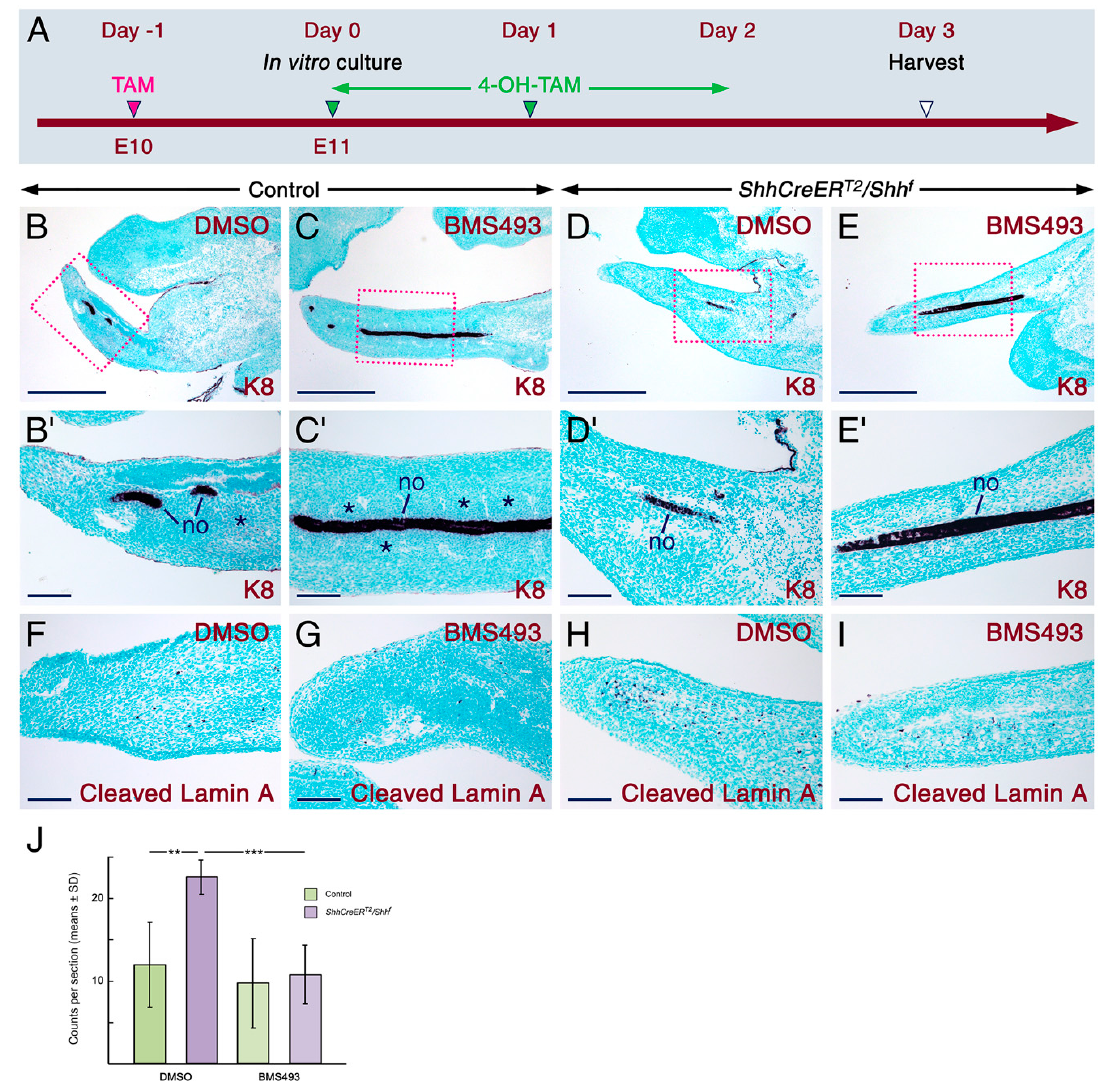
Figure 3. In vitro inhibition of retinoic acid signaling partially rescues the tail phenotype of SHH-deficient embryos. ( A ) Timeline representing the induction of CRE-mediated deactivation of Shh in embryos and in tail explants. The tails are from E11 control and ShhCreER T2 /Shh f mutant embryos first exposed in utero to tamoxifen (TAM) at E10 (red arrowhead). All tail explants were cultivated in vitro for two days in the presence of 4-hydroxytamoxifen (4-OH-TAM; green arrowheads). During the in vitro cultivation period (three days), the tails were treated with DMSO or 12.5 µ M BMS493. The time of harvest of the explants is indicated by a white arrowhead. ( B – E ) Representative Keratin 8 (K8; dark purple) immunostaining visualizing the notochord (no) in sections of tail explants from control and mutant embryos. The tails were treated with DMSO ( n = 5 controls and n = 6 mutants) or BMS493 ( n = 13 controls and n = 8 mutants). B’ – E’ are magnified images of the boxed areas in B – E . All the control tails treated with DMSO ( B , B’ ) or BMS493 ( C , C’ ) exhibit a notochord and chondrogenic mesenchymal condensations (asterisks in B’ and C’ ). All the DMSO-treated mutant tails lack a notochord in the posterior region, while in the rostral region they display an abnormally thin notochord ( D , D’ ). The BMS493-treated mutant tails ( E , E’ ) display a notochord ( n = 6 / 8), but fail to exhibit chondrogenic mesenchymal condensations ( n = 8 / 8). ( F – I ) Representative sections of tail explants from control and mutant embryos were immunostained for cleaved Lamin A (dark purple) to visualize apoptotic cells. Massive apoptosis in the DMSO-treated mutant tails ( H ; n = 6) as compared to the BMS493-treated mutant tails ( I ; n = 6) and the DMSO-treated ( F ; n = 3) and BMS493-treated ( G ; n = 7) control tails. ( J ) Quantitation of apoptosis in tail explants (the number of explants assessed